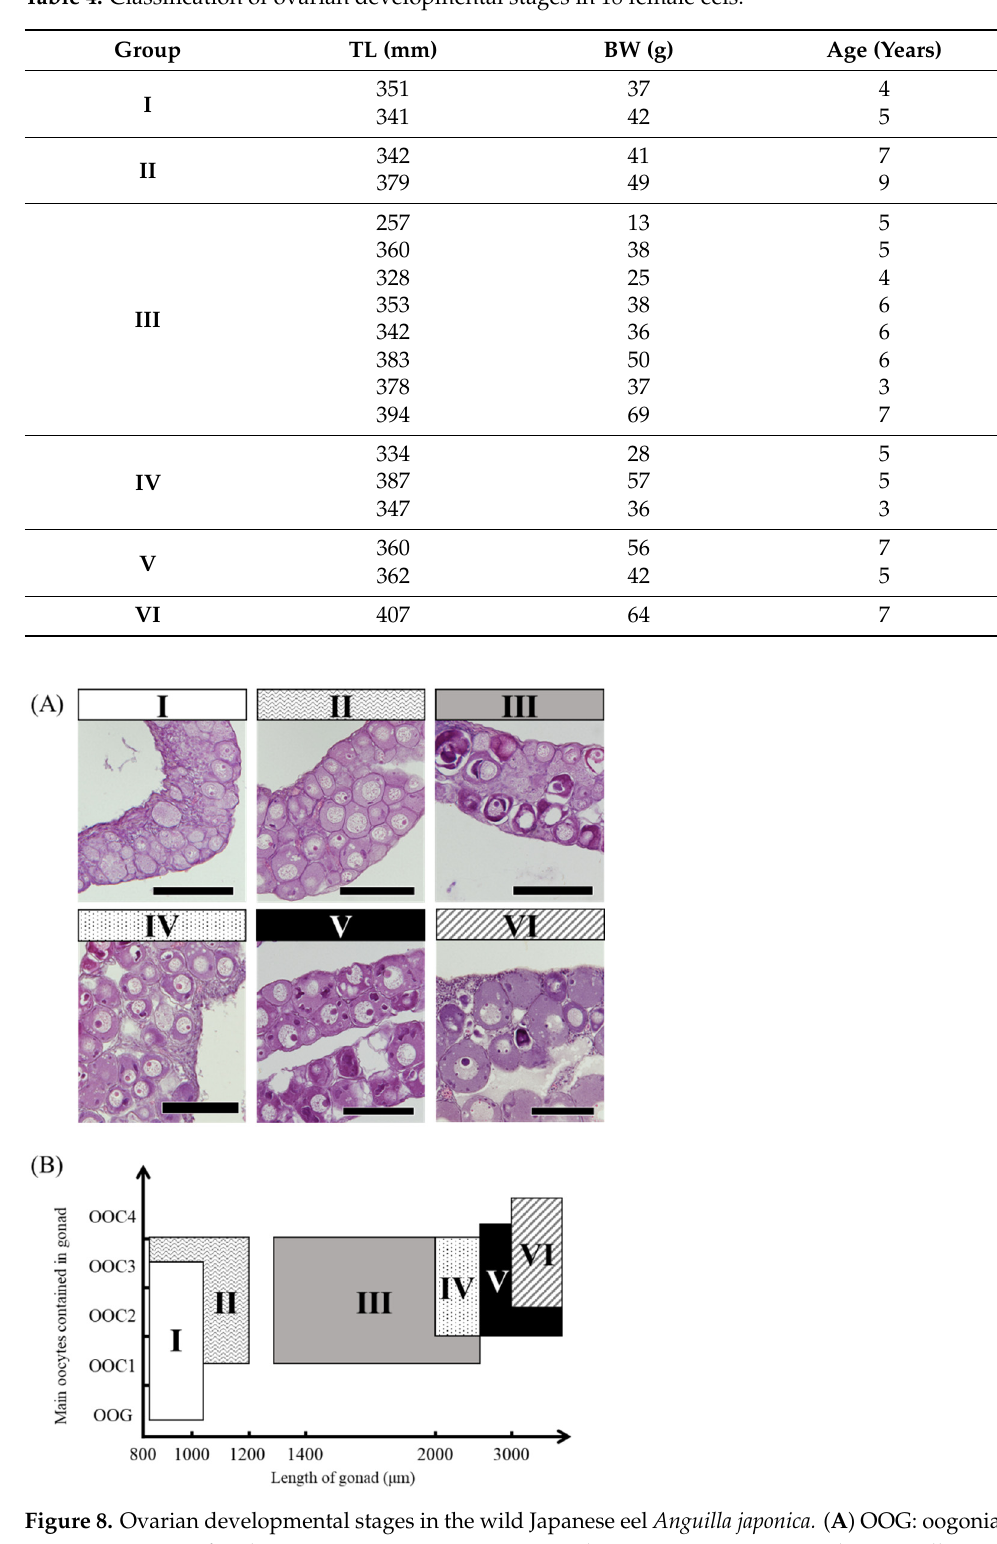
Table 4. Classification of ovarian developmental stages in 18 female eels.